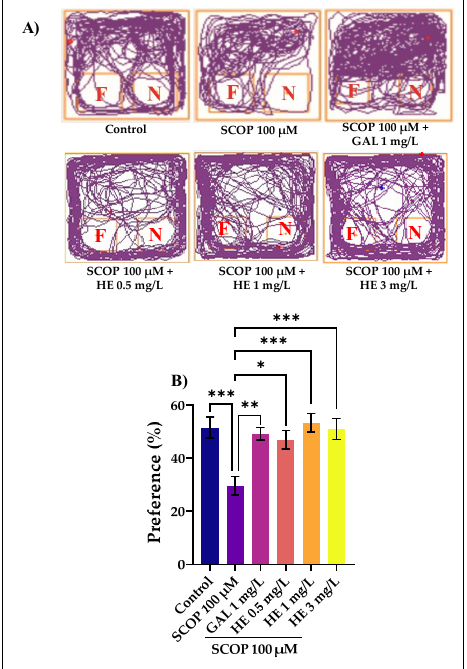
Figure 4. Hericium erinaceus ethanolic extract (HE: 0.5, 1, and 3 mg/L) improved memory in the novel object recognition test (NOR). ( A ) Representative locomotion-tracking pattern of the control, scopolamine (SCOP: 100 μ M), (HE: 0.5, 1, and 3 mg/L), and galantamine (GAL: 1 mg/L) treated groups. ( B ) Representation of the percentages of preference in different groups. Values are means ± S.E.M. ( n = 10). For Dunn’s post hoc analyses: *** p < 0.001, ** p < 0.01, and * p < 0.05.